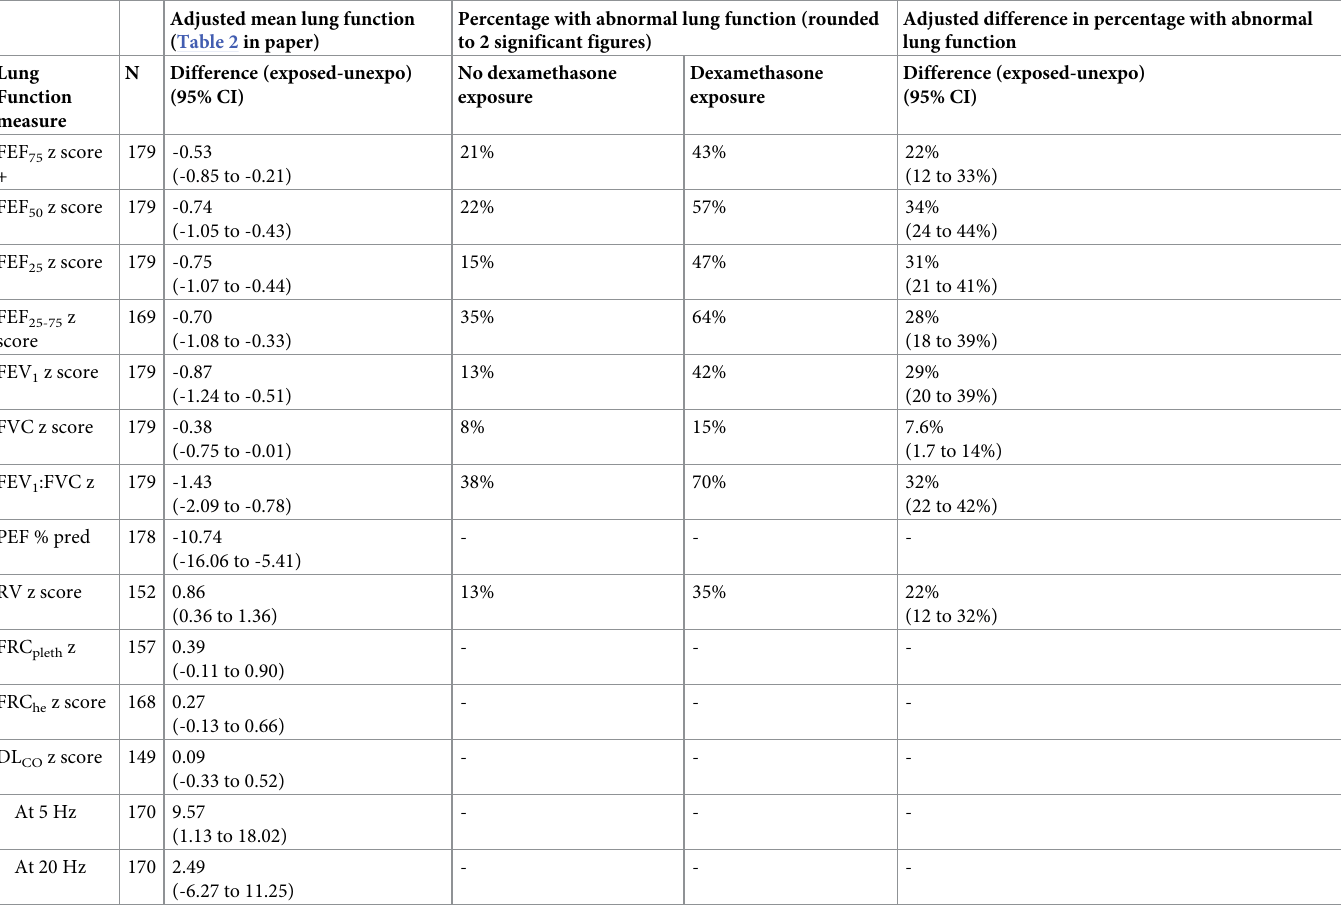
Table 3. Adjusted differences in mean lung function with equivalent differences in the proportions (as percentage) with abnormal lung function (below/above 5 th centile for healthy population (cid:3) ). Adjusted mean lung function (Table 2 in